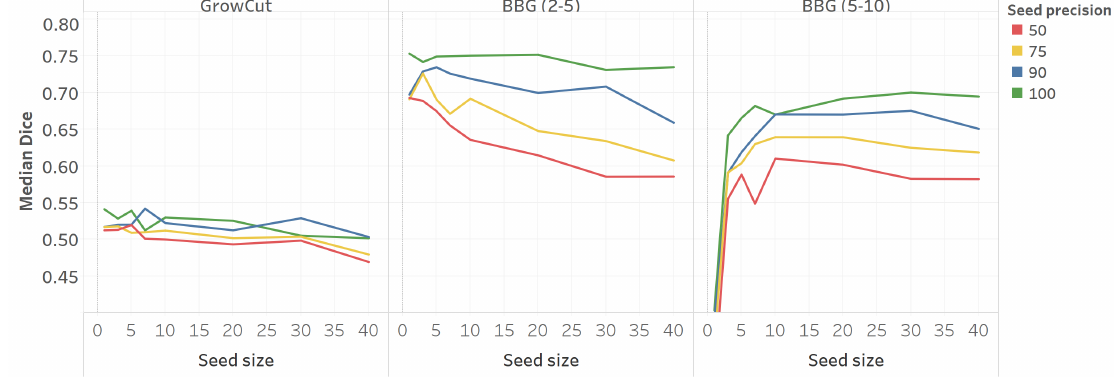
Figure 5. Median Dice value as a function of seed size and seed precision (imATFIB dataset). Table 3. ω 2 statistic (effect size) for the seed size and precision factors (imATFIB dataset).